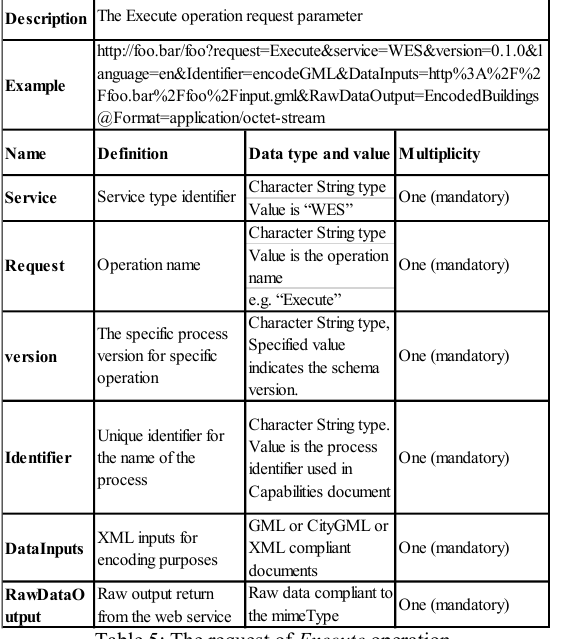
Table 5: The request of Execute operation.